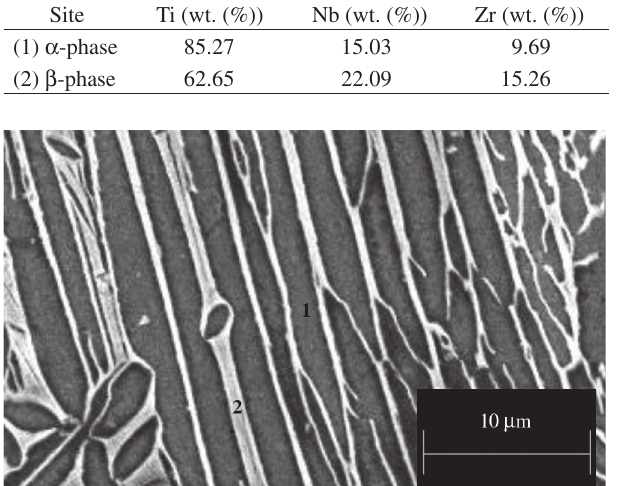
Figure 3. α -phase (1) and β -phase (2) areas analyzed by EDS in Ti-13Nb-13Zr